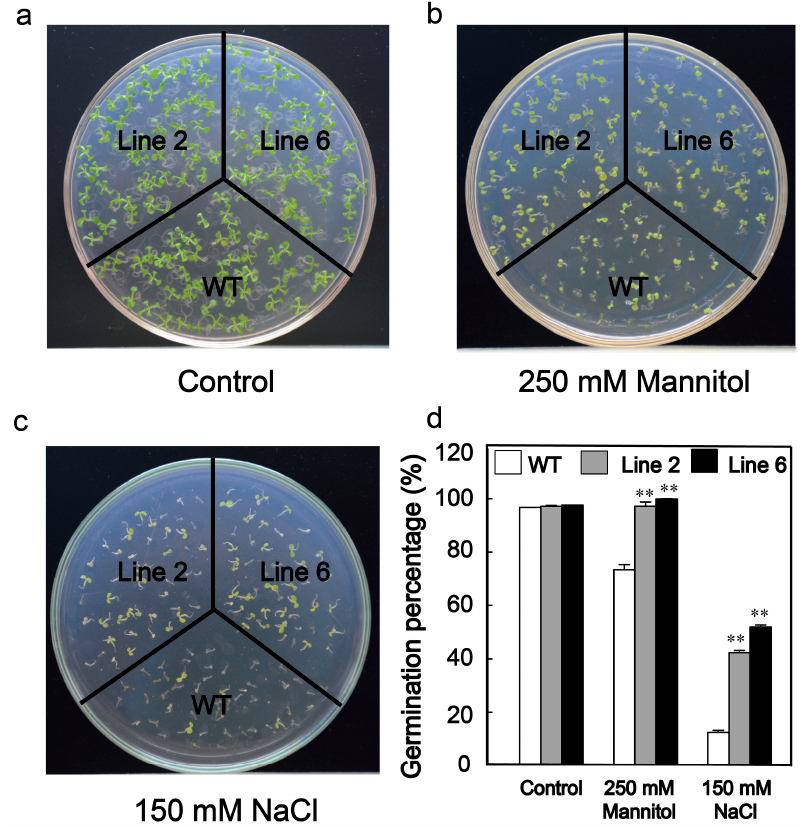
Figure 3. Determination of seed germination percentage under osmotic and salt stresses. Comparison of germination levels between wild type (WT) and ScDREB10 -transformed seeds under normal ( a ), 250 mM mannitol ( b ), and 150 mM NaCl ( c ) treatment conditions. The Arabidopsis ecotype Col-0 was used as WT. ( d ) Germination percentage of WT and ScDREB10 -transformed seeds under mannitol and NaCl treatment conditions 7 days after sowing. The germination percentage was calculated as the number of germinated seeds divided by the total number of seeds, represented as a percentage. Values are means ± SE of three replicates ( n = 40–60 seeds). Asterisks indicate statistically significant differences from WT (** P <